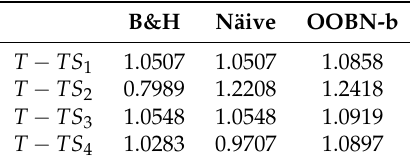
Table 11. Comparison of the performance among the Buy and Hold (B&H), the Näive and the OOBN-based (OOBN-b)